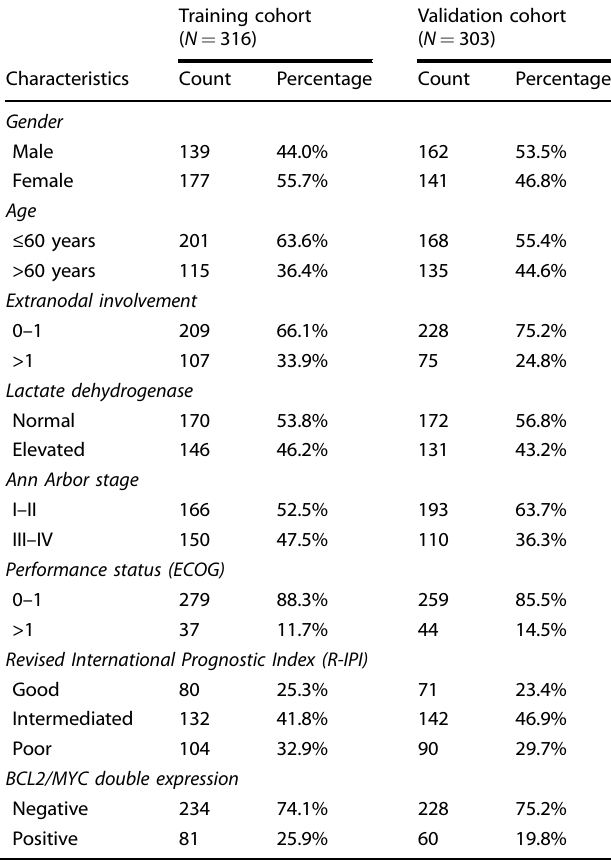
Table 1. Clinical and pathological characteristics of DLBCL patients Training cohort ( N =